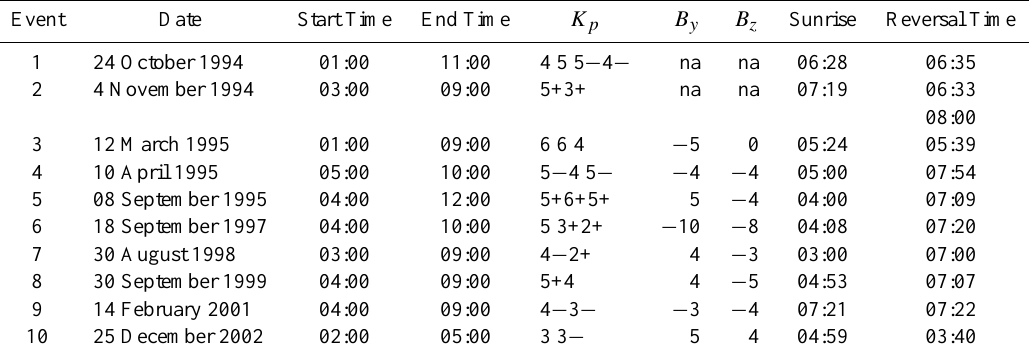
Table 1. Selected periods of the IRIS